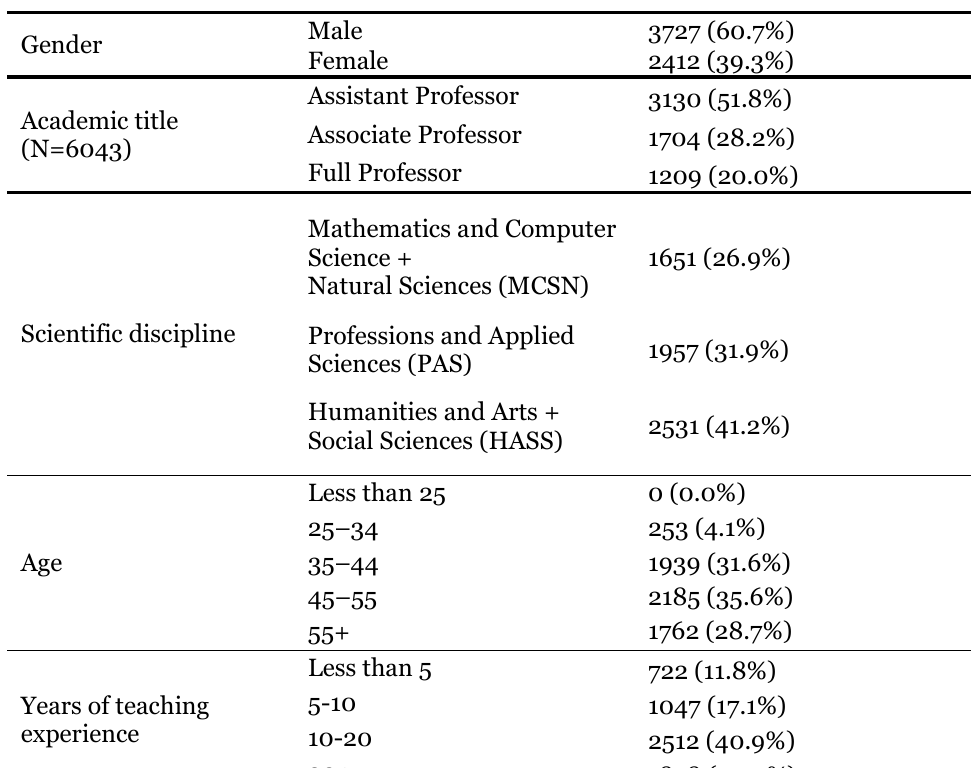
Table 1 Socio-Demographics and Professional Characteristics of the Sample (N=6139)